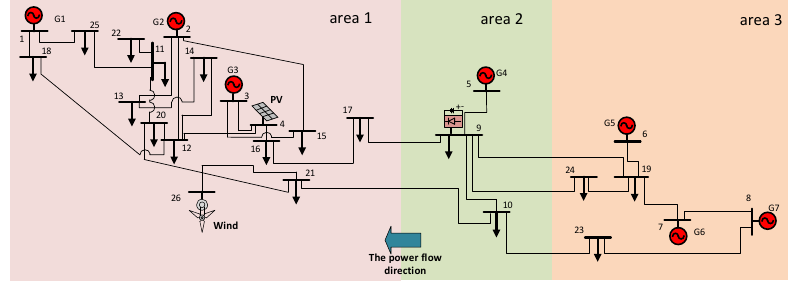
Figure 4. Java, Indonesia power grid representative model. Table 1. Damping performance of Java, Indonesia grid.